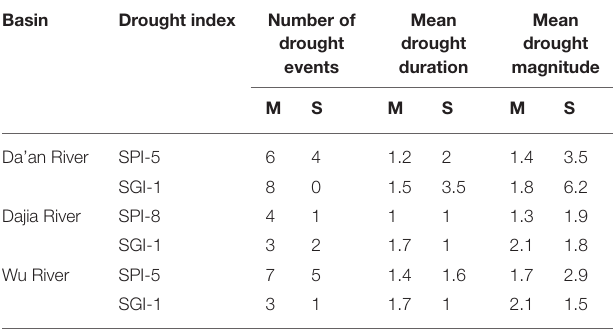
TABLE 4 | Drought characteristics for moderate and severe drought of each basin. Basin Drought index Number of